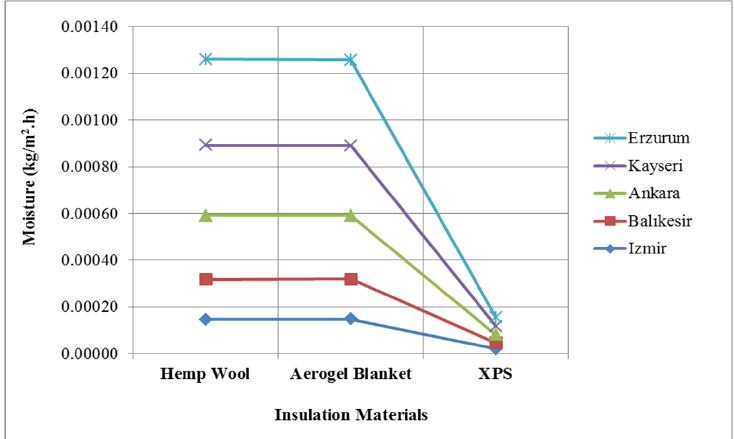
Figure 13. Moisture values for different insulation materials for hollow brick wall.